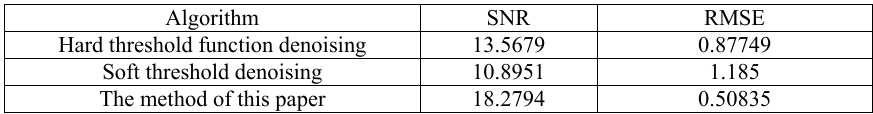
Table 1. A table with SNR and RMSE of three algorithms.